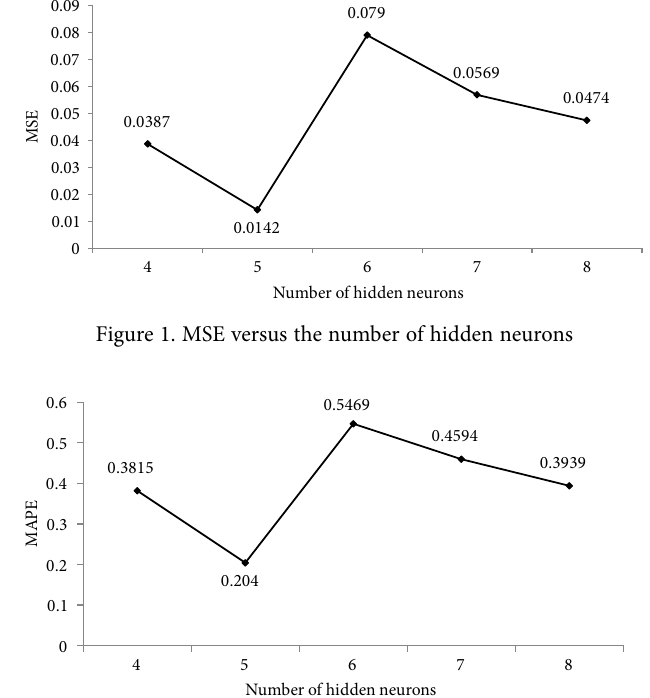
Figure 2. MAPE versus the number of hidden